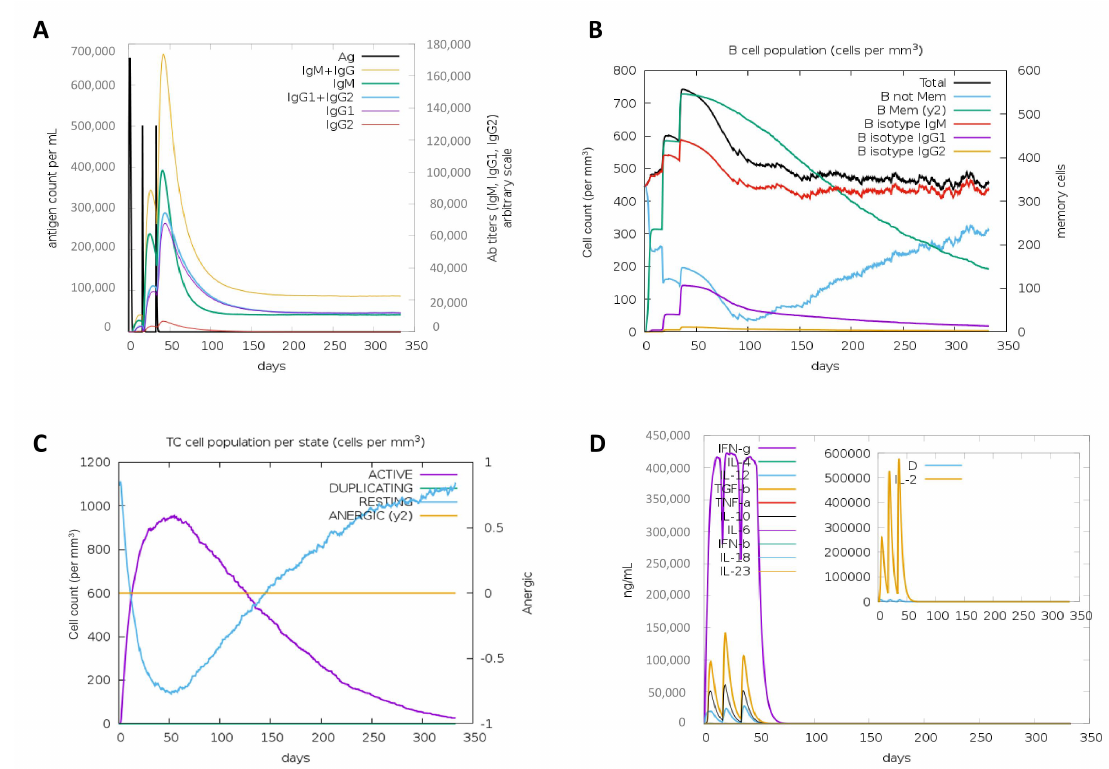
Figure 6. Simulated immune response after administration of the vaccine construct: The graphs show stimulation of ( A ) IgG, IgM, and total antibody response, ( B ) Effector and memory B cell response, ( C ) Active and anergic CD8+ T cell response, and ( D ) IFN-gamma and other cytokine responses after vaccine administration; ( D ) (insert): plot shows levels of danger signal (positive or negative signals immune systems generate in response to ‘danger’ such as pathogens (Ramadan et al., 2017)) together with leukocyte growth factor IL-2 over